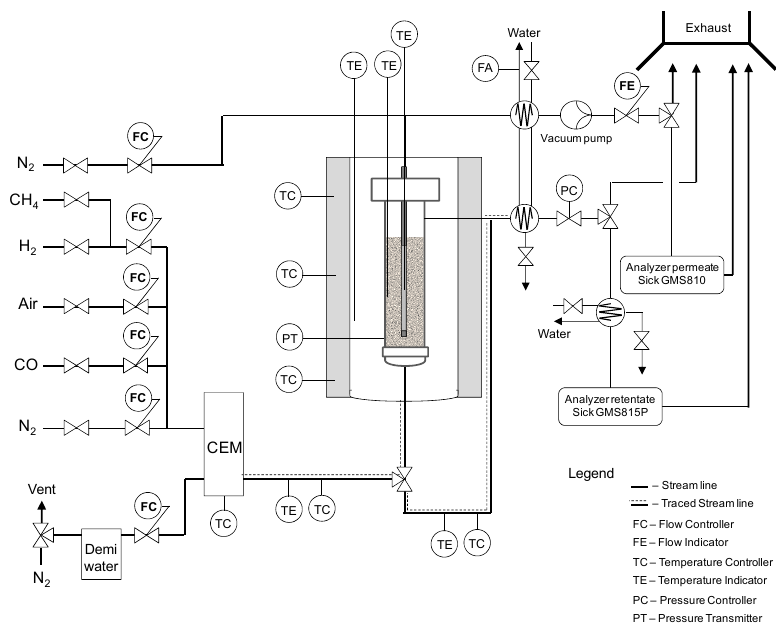
Figure 9. PID of the fluidized bed membrane reactor used for the WGS lab scale demonstration [37].